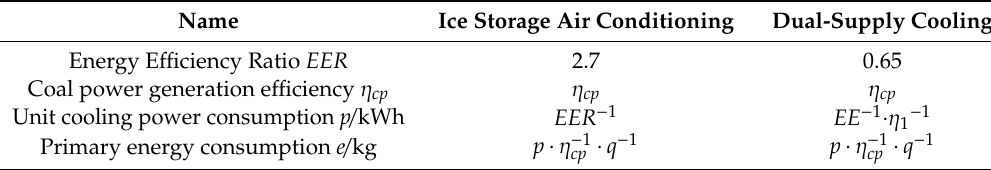
Table 2. Summer cooling energy consumption and cost parameters [21].